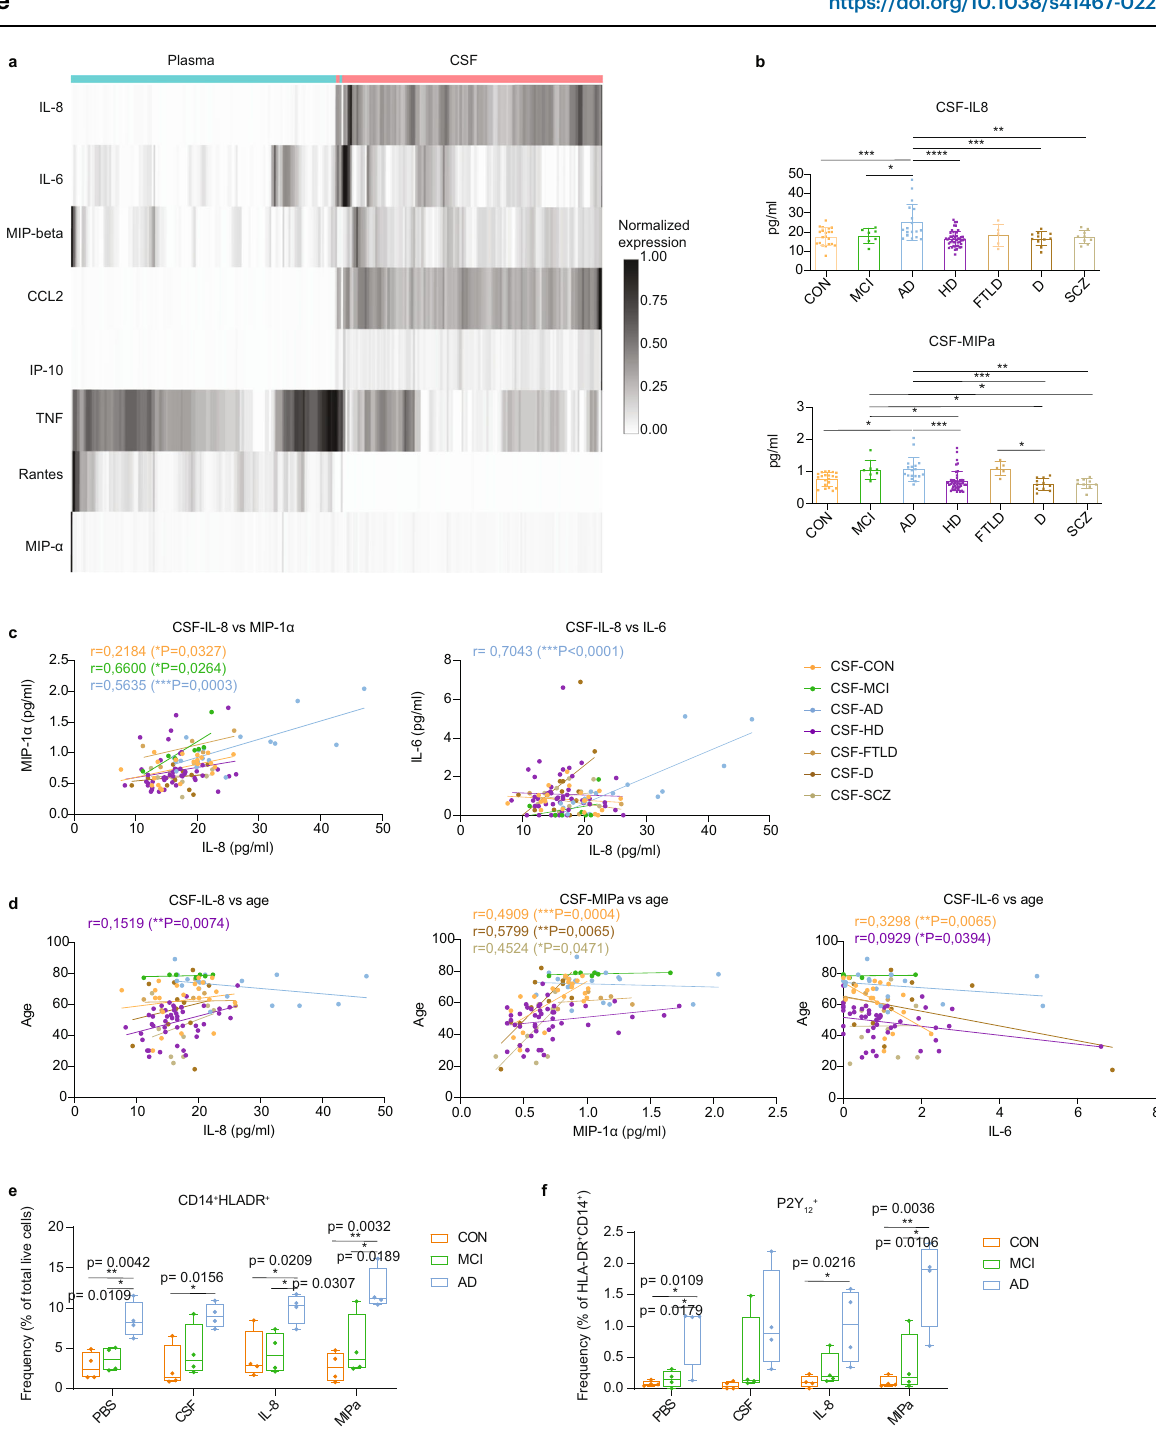
correlation between mean IL-8 and MIP-1 α or IL-6 concentration and age of all groups. * P <0.05, ** P <0.01 and *** p <0.001, nonparametric Spearman correlation test (r),two-sided. e , f Results obtained from invitroexperiments, inwhichPBMCs fromCON( n =4, biologicalreplications),AD( n =4, biologicalreplication)and MCI ( n =4, biological replication) individuals treated with either PBS, CSF, IL-8 or MIP- 1 α .FlowcytometryanalysisrevealedincreasedfrequencyofCD14 + HLA-DR + cells(% of totallivecells, e )and P2Y 12 + cells(% of HLA-DR + CD14 + cells, f )inAD-PBMCs after in vitro incubation (PBS) or after treatments (CSF , IL-8 and MIP − 1 α ). Boxes extend from the 25th to 75th percentiles. Whisker plots show the min (smallest) and max (largest) values. The line in the box denotes the median. Each dot represents the value of each sample. Ordinary one-way ANOVA; * p <0.05, ** p <0.01, *** p <0.001. Source data (for b , c , d, e and f ) are provided as a Source Data fi